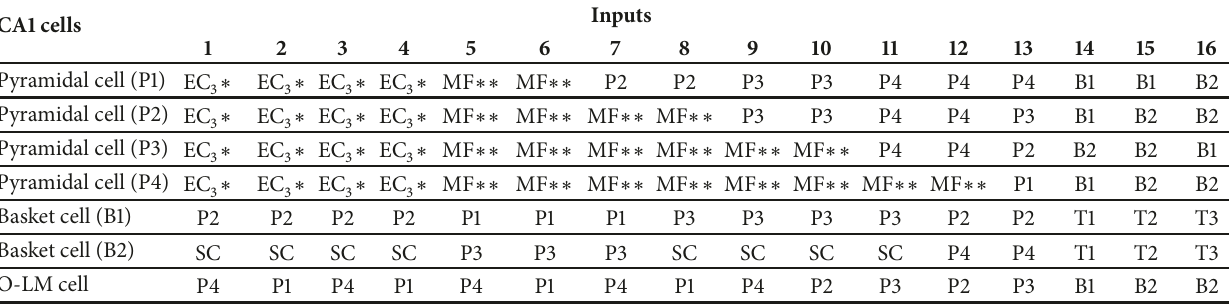
Table 3: Connections of hippocampal CA1 microcircuit.